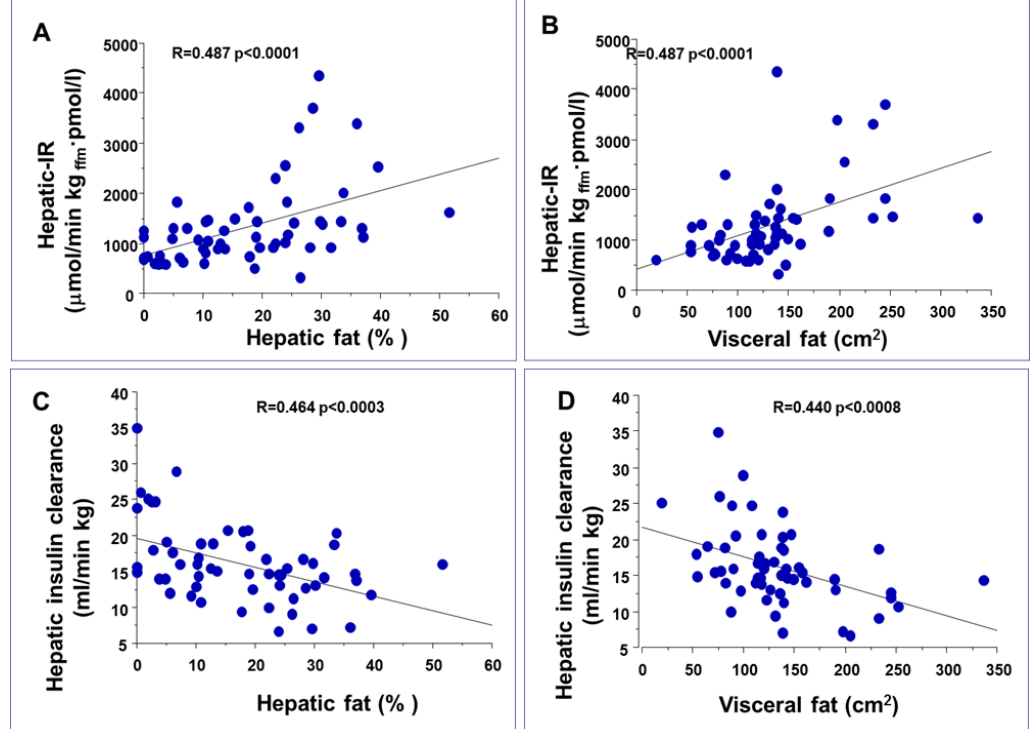
Figure 3. Similar correlations between liver and visceral fat accumulation, hepatic insulin resistance ( i.e ., the resistance to the effect of insulin to reduce fasting hepatic glucose production), top panels A and B , and between liver and visceral fat and hepatic insulin clearance, bottom panels C and D . Data redrawn from